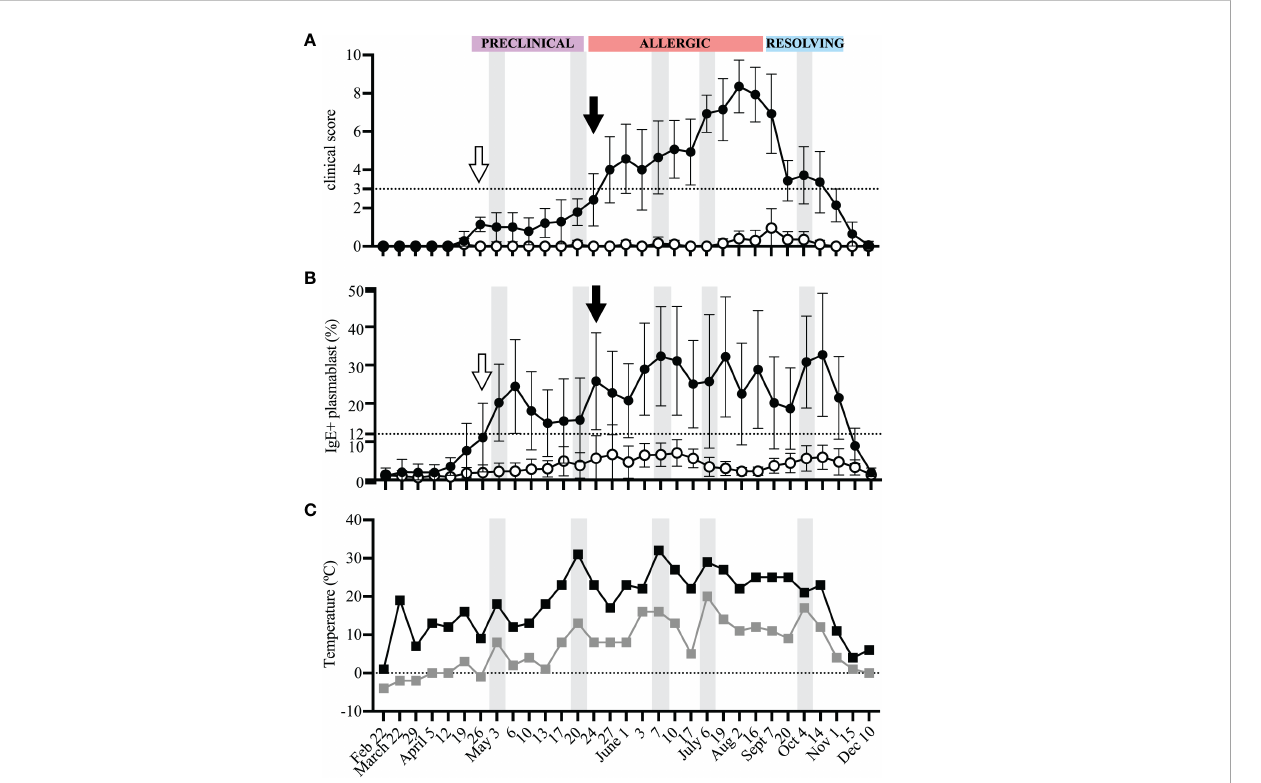
FIGURE 2 IgE + plasmablasts appear in peripheral blood before the onset of clinical allergy. PBL were frequently collected from heparinized blood samples for the duration of one year to compare the onset of IgE+ plasmablasts in peripheral blood and the development of clinical allergy. Samples were collected from allergic (n=7, black circles) and healthy (n=10, open circles) horses (A) Clinical scores (0-10) were assigned to each horse at each timepoint using the Cornell allergy scoring system described by Miller et al. (29). The dotted horizontal line denotes the threshold ≥ 3 where allergic horses have clinical allergy. The three phases of the allergen exposure season (Preclinical, Allergic and Resolving) are labeled in purple, red and blue boxes, respectively. (B) The frequency of IgE + plasmablasts was measured at each timepoint. The dotted horizontal line represents the threshold were allergic horses have ≥ 12% IgE + plasmablasts. (C) Daily minimum (gray squares) and maximum (black squares) temperatures (°C) were recorded at each blood sampling timepoint. (A-C) Gray vertical bars show high temperature peaks (May 3, May 20, June 7, July 6, October 4). (A, B) Open arrows (April 26) show the fi rst day of IgE + plasmablasts above the threshold of 12% in allergic horses. Black arrows (May 24) show fi rst day when clinical allergy scores above the threshold of 3 were given to allergic horses. Graphs show mean and standard